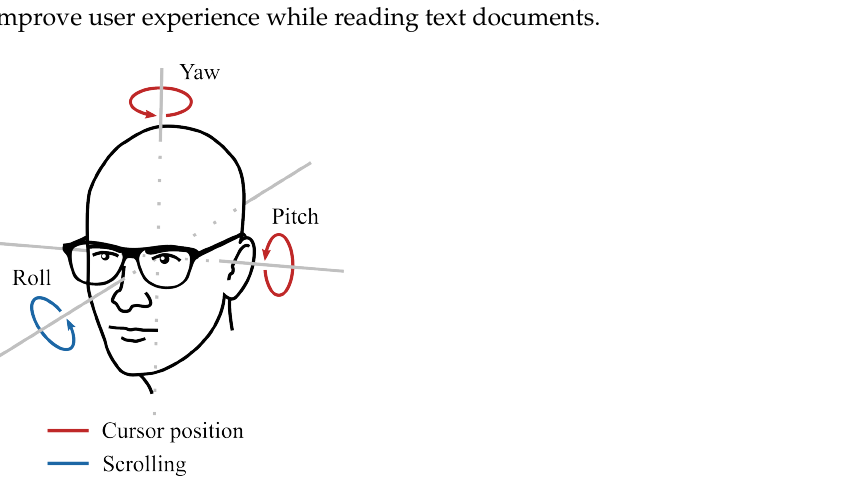
Figure 4. Yaw and pitch (red) motions determine mouse cursor position, while roll movements (blue) control up and down scrolling. Modified from Gür et al.